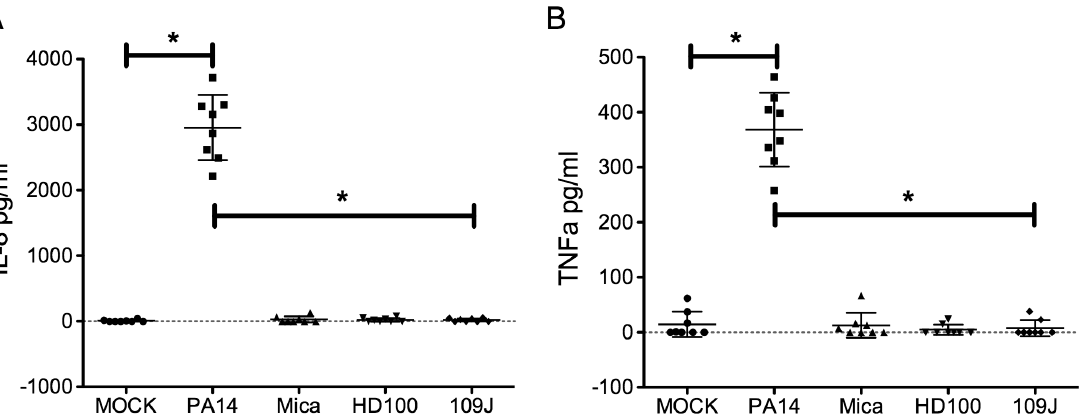
Figure 2. Inflammatory response of human corneal-limbal epithelial cells to predatory bacteria invitro . Pro-inflammatory cytokines IL-8 (panel A) and TNF- a (panel B) were measured using ELISA assays. Cell supernatants taken from HCLE cells after 4 hrs of incubation with positive control Pseudomonas aeruginosa strain PA14 (average MOI = 111), detergent lysis (LYSIS), medium only negative control (DNB), and experimental strains B. bacteriovorus strain 109J (avgerage MOI = 4720), B. bacteriovorus strain HD100 (average MOI = 1039), and M. aeruginosavorus (Mica, average MOI = 853). Total independent data points from 2 experiments are shown. Asterisks indicate significant differences (p , 0.001, ANOVA with Tukey’s post-test). Only PA14 was significantly different than MOCK. Error bars indicate one standard